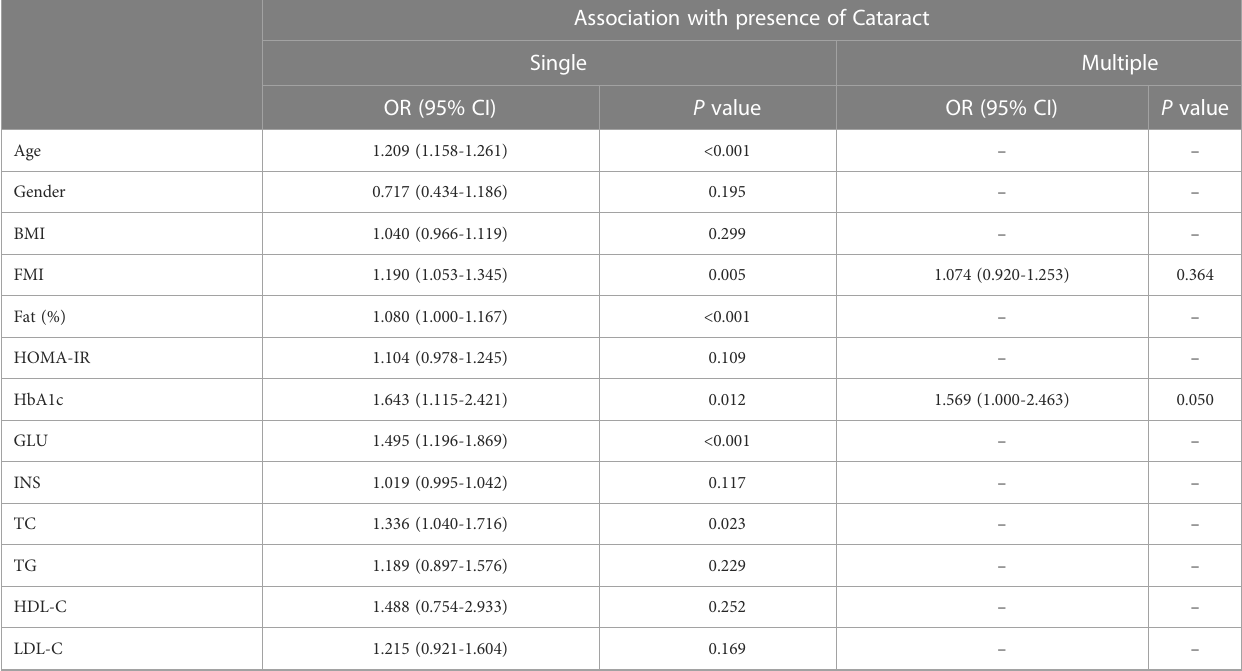
TABLE 6 Univariable and multivariable logistic regression analyses for